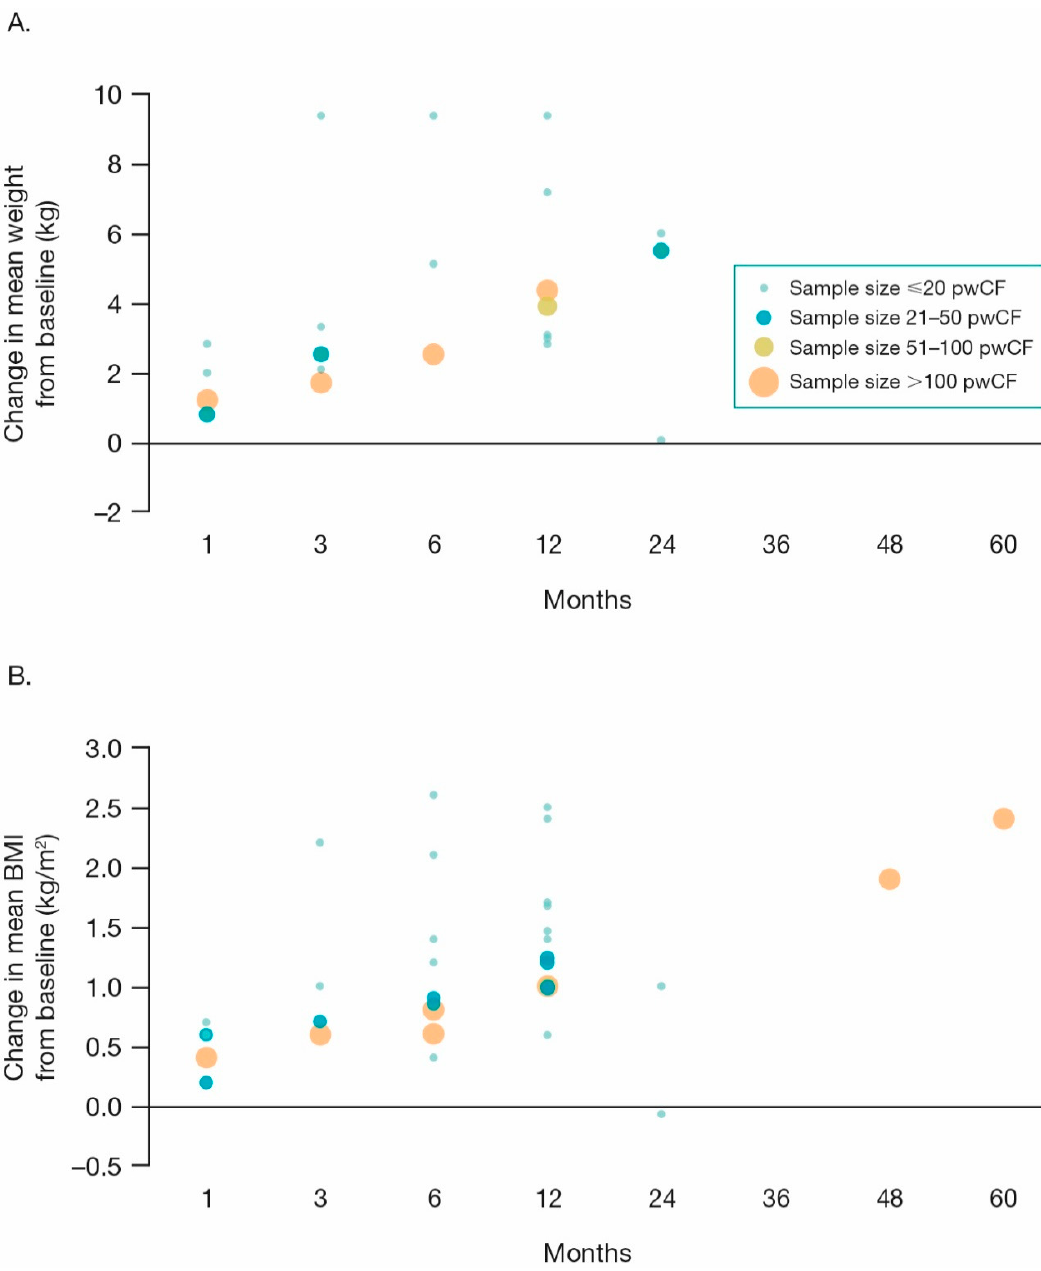
Figure 4. Change in mean weight ( A ); 10 studies) and mean BMI ( B ); 17 studies) with ivacaftor treatment [30,34,37,40,42,44–46,49,51,53,58,66,69,71–73,75,78,83,86,92,96,98,99,101]. Note: Figure only includes studies reporting absolute change from baseline within the ivacaftor-treated cohort in BMI and/or weight at 1, 3, 6, 12, 24, 36, 48, and/or 60 month time points following ivacaftor treatment. BMI: body mass index; pwCF: people with cystic fibrosis.